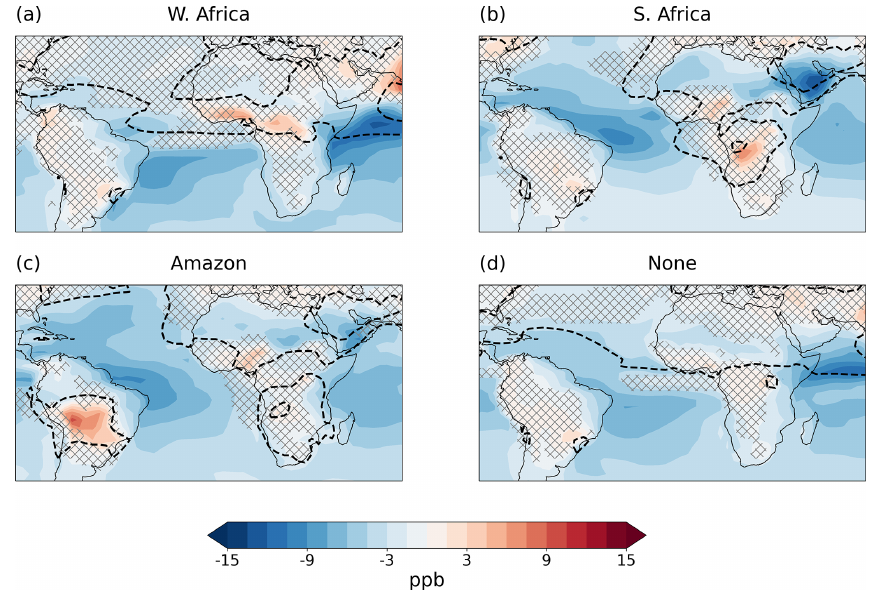
Figure 4. The multimodel mean change in surface O 3 concentration due to climate change for the period 2090–2100 for (a) the western African burning season (December–February), (b) the southern African burning season (June, July), (c) the southern Amazon burning season (August–October) and (d) the remaining months with limited burning (March–May, November). Grey hatching covers areas where models disagree on the sign of the change due to climate change. Black dotted lines outline areas where background O 3 is 40 and 70ppb.